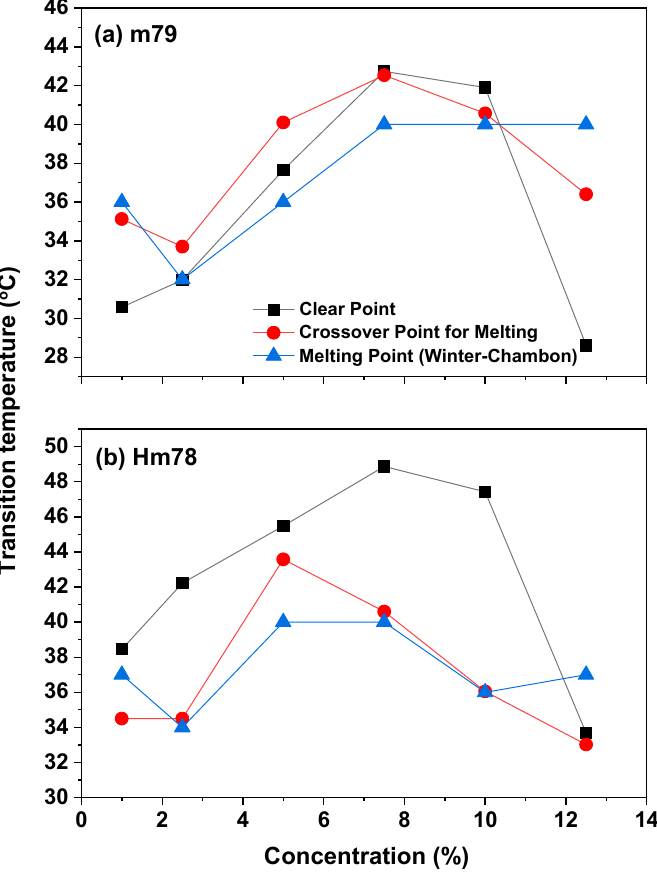
Figure 11. The G ’- G ” crossover point for melting ( (cid:8) ), the melting point determined by Winter-Chambon criterion ( (cid:78) ), and the clear point determined by transmittance measurement ( (cid:4) ), as a function of the concentration for ( a ) m79 and ( b ) Hm78 Figure 11. The G’-G” crossover point for melting ( ● ), the melting point determined by Winter- Chambo n criterion ( ▲ ), and the clear point determined by transmittance measurement ( ■ ), as a function of the concentration for ( a ) m79 and ( b ) Hm78 solutions.